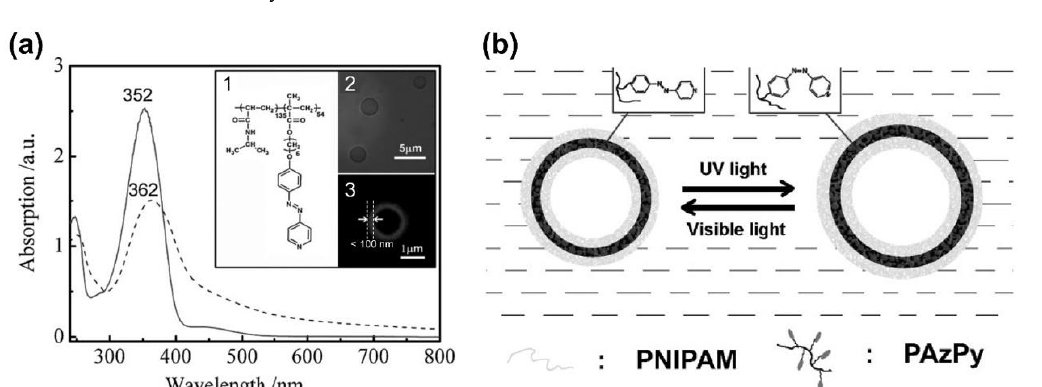
Figure 11. ( a ) Absorption spectra of the copolymer in THF solution (solid line) and in the mixture of THF and H 2 O as vesicles (dashed line). The inset shows (1) the chemical structure of the deblock copolymer; (2) images were obtained using the optical microscope and (3) laser scanning confocal microscopy, respectively; ( b ) Schematic representation of UV-induced swelling and shrinking behaviors from block copolymer vesicles. Reprinted with permission from [69]. Copyright 2008, WILEY.